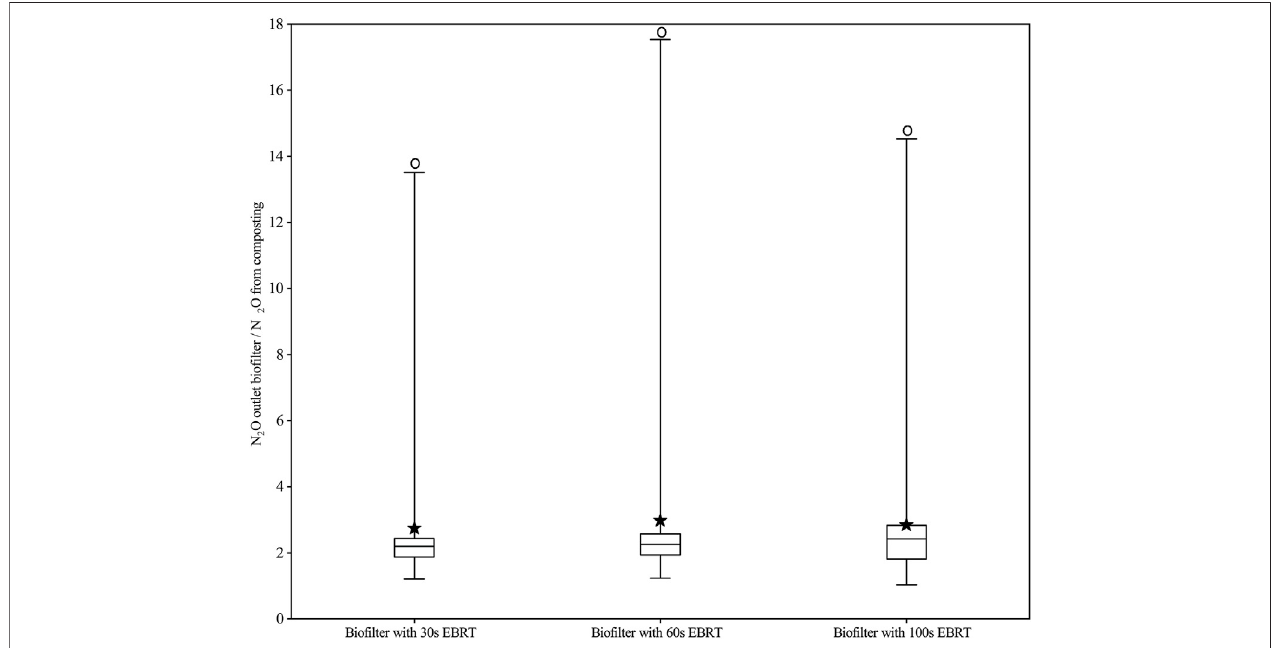
FIGURE 3 | Boxplot: Ratio of N 2 O concentration of the outlet and inlet at different bio fi lters (Box border means 25 and 75% percentile, the solid line in the box meansthemedianvalue,thesolidpentaclemeansthemeanvalue,whiskermeansthemaximumandminimumvalues,andthewhitecirclemeanssigni fi cantdifferences between the inlet and outlet).